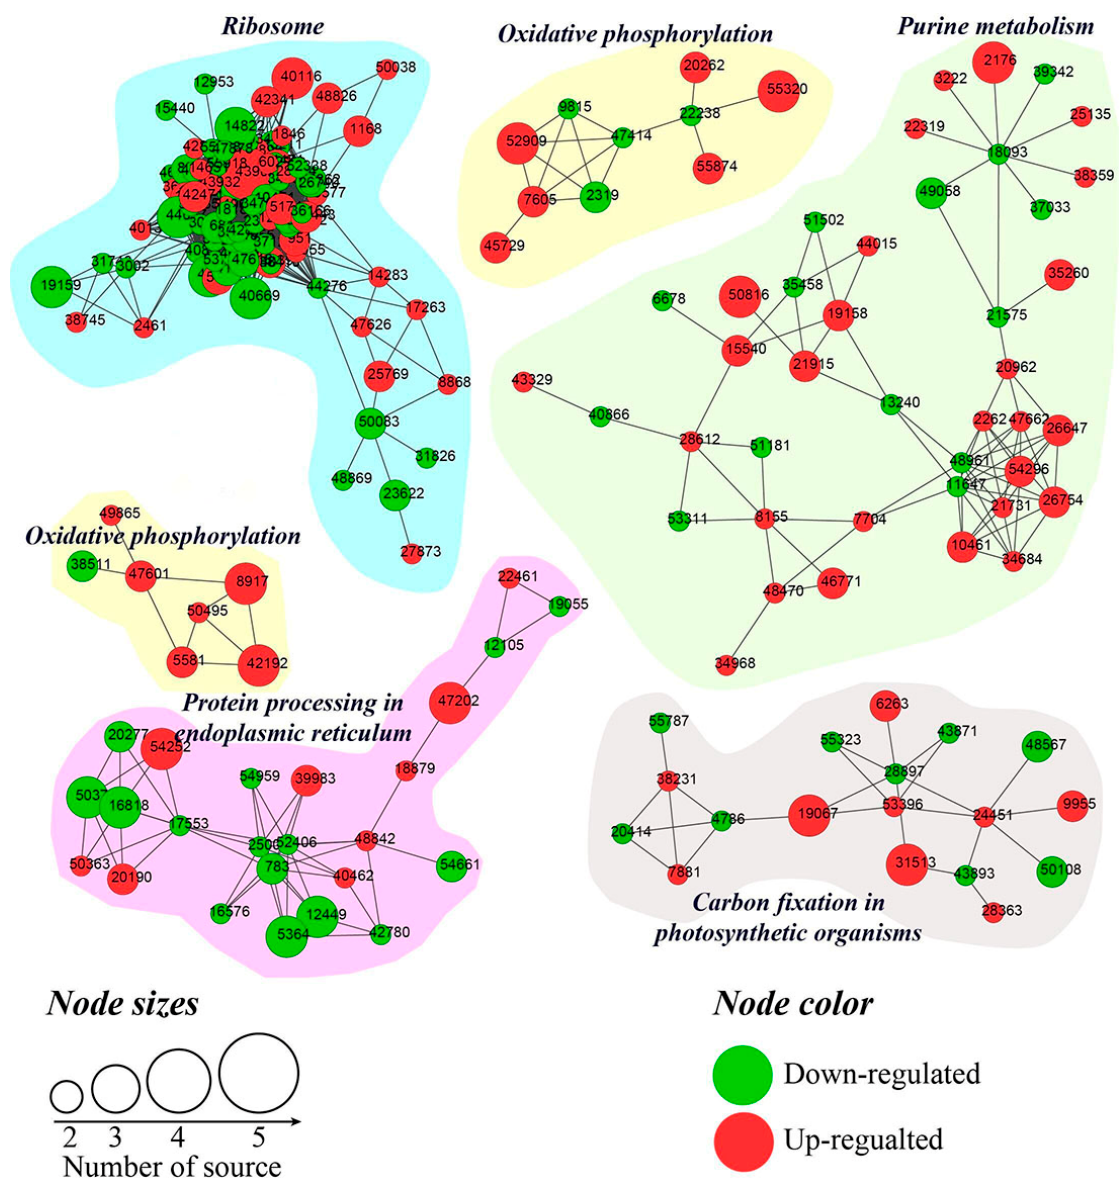
Figure 7. Functional correlation network of DAPs.